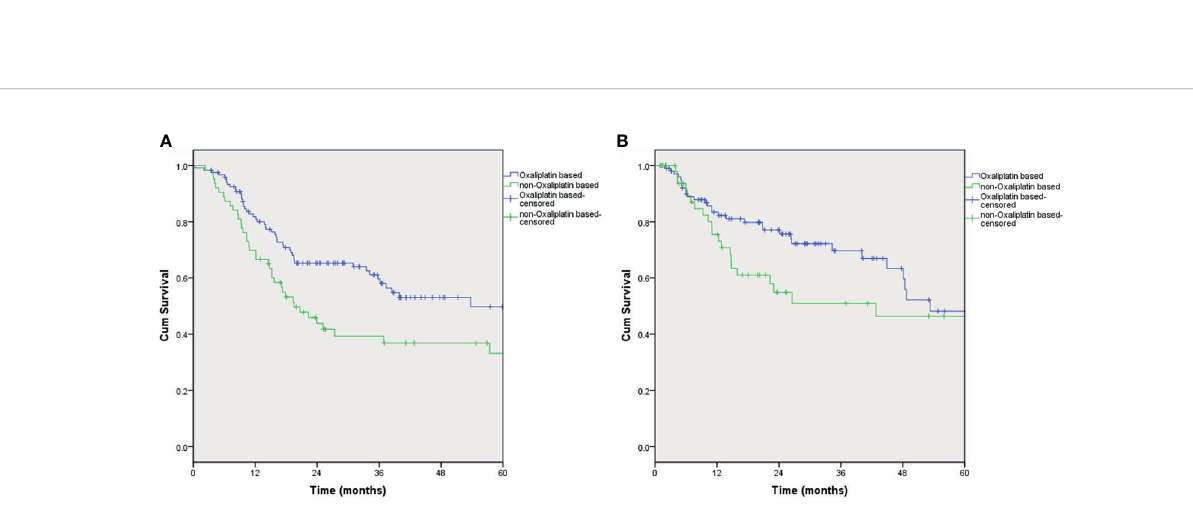
FIGURE 3 | Overall survival and recurrence-free survival of non-SRCC patients who received the oxaliplatin-based regimen. (A) Overall survival, P=0.011; (B) Recurrence-free survival,